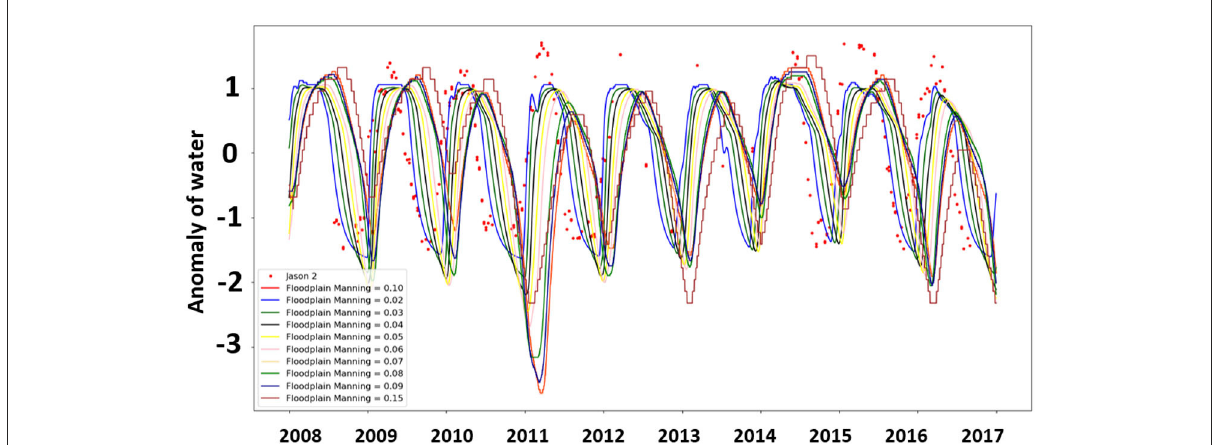
FIGURE12 Comparison of the different Manning coefficients in the floodplain and the anomaly of water height time series for Jason 2 (red dots). Each color represents a different Manning coefficient for the floodplain leading to different velocity and a different magnitude of the flooding. This is extracted from sub-basin n ◦ 295 under track n ◦ 241 at the latitude